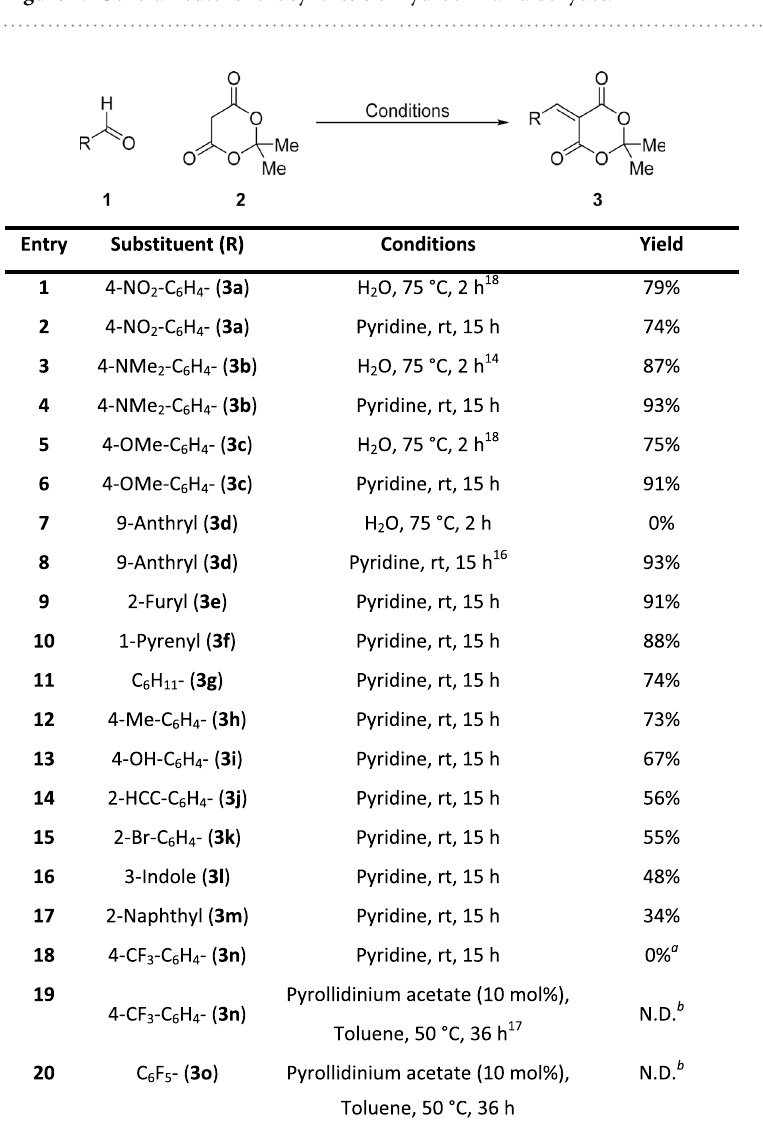
Figure 1. General route for the synthesis of hydrocinnamaldehydes.